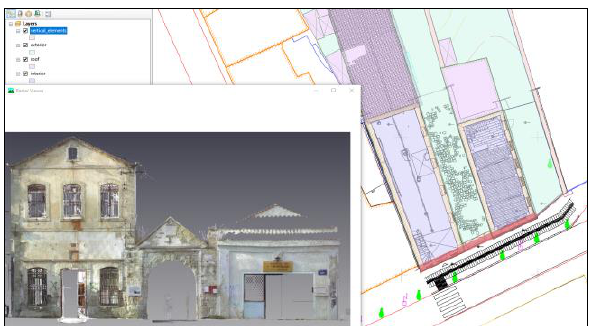
Figure 18 . The GIS application (linkage of features classes with laser scanner data).